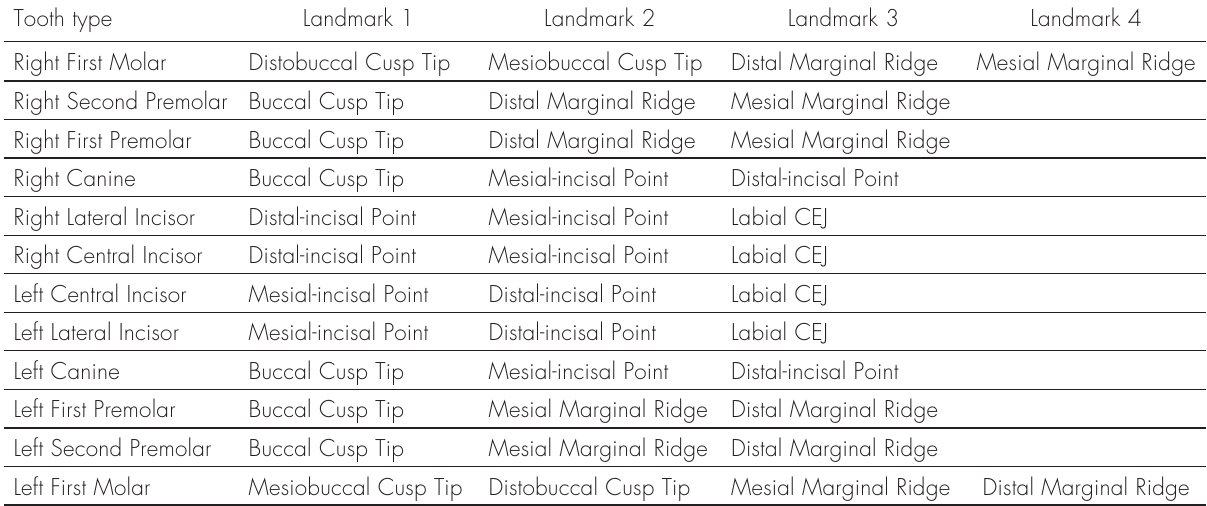
Table I. List of dental landmarks used in the study on each type of tooth. Tooth